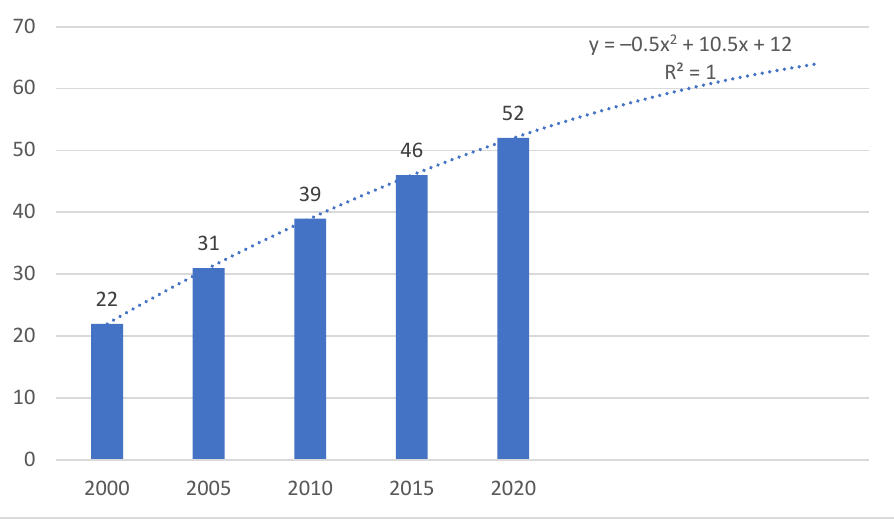
Figure 3. The forecast of the need for soft skills in the workplace. Source: the authors based on data from (Rasli et al. 2020).